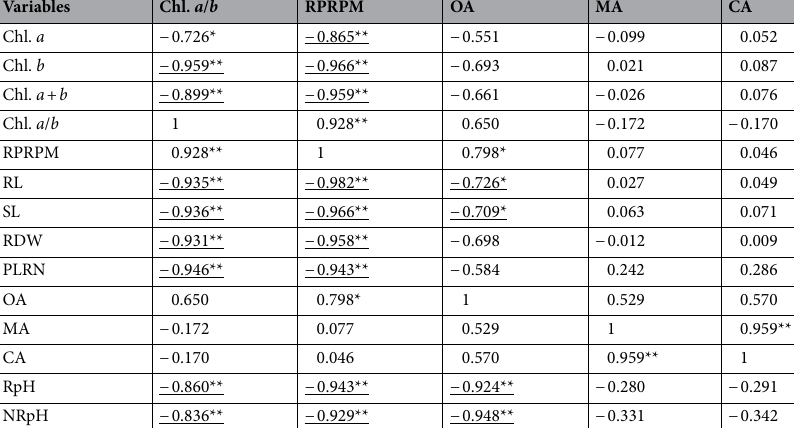
Table 2. Correlation coefficients ( r ) among the photosynthetic traits, morphology indexes, and root physiological parameters for the pine seedlings of families Nos. 35 and 79, which were exposed to the SAR at pH of 5.6, 4.5, 3.5, and 2.5. **, and * = significant at 0.01 and 0.05 levels, respectively. The underlined data indicates a significant negative correlation between the two indicators. Chl. a chlorophyll a , Chl. b chlorophyll